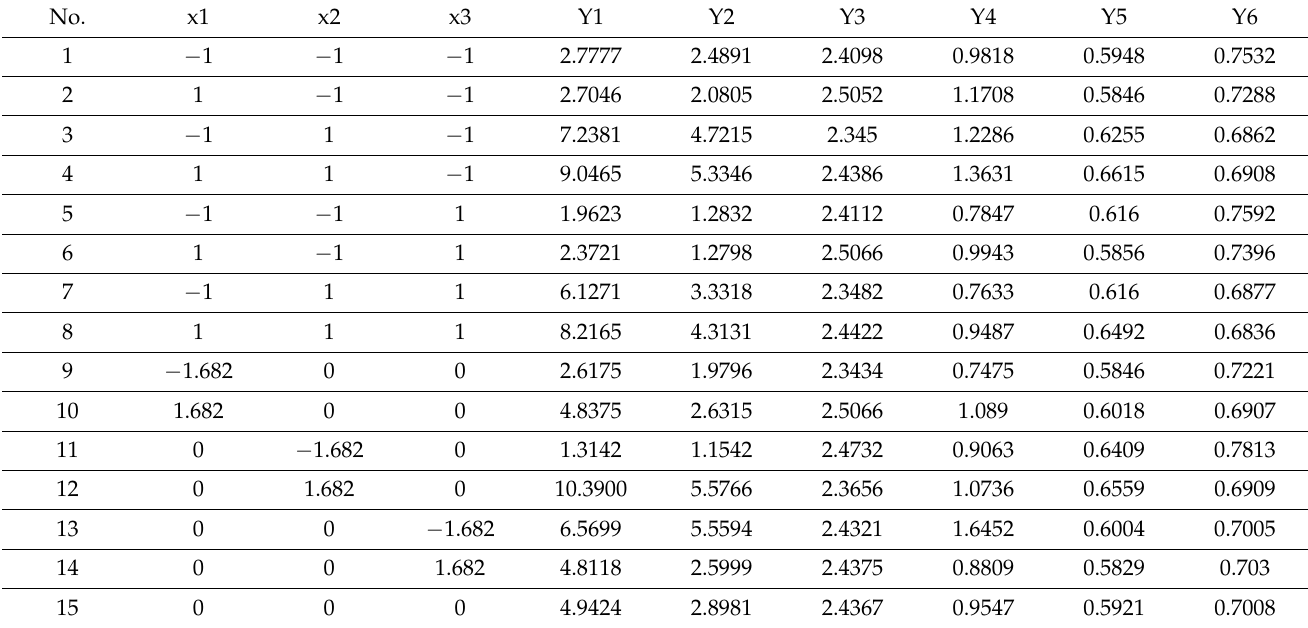
Table 2. Simulation results of the